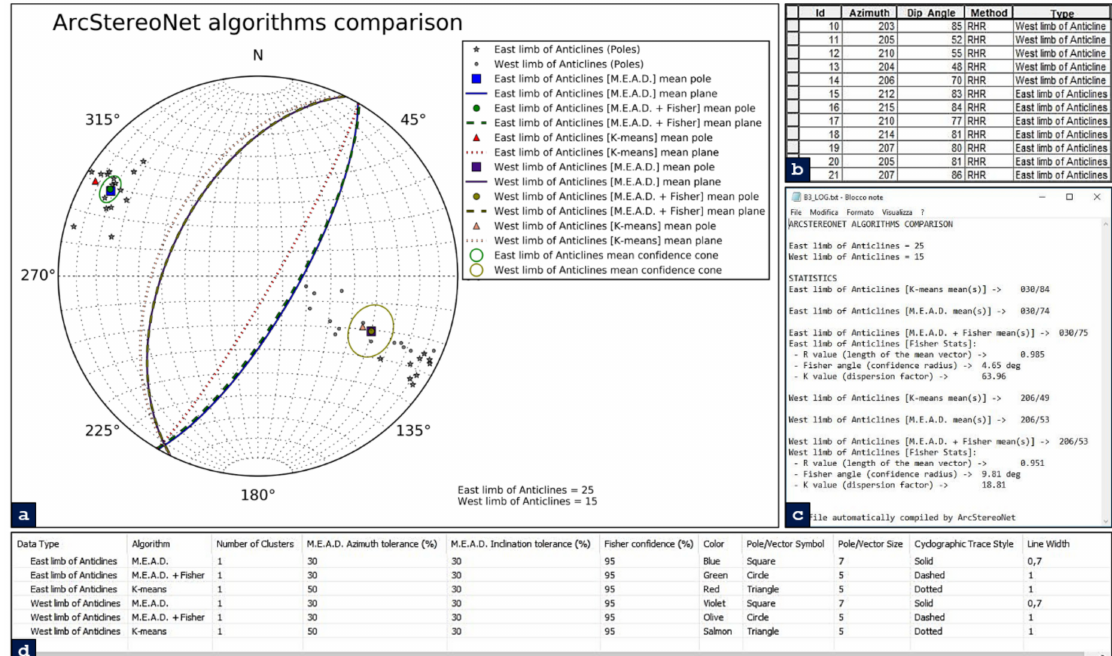
Figure 11. Application of ArcStereoNet algorithms with customised control parameters for the extraction of mean vectors from the Macduff area dataset, grouped in two different feature types. ( a ) ASN graphic result; ( b ) portion of Macduff dataset attribute table, with records displaying two different feature types (i.e., ‘East limb of Anticlines’ and ‘West limb of Anticlines’); ( c ) ASN log file showing algorithm statistics and results; and ( d ) ‘Extract Mean Vector’ Value Table showing the algorithm